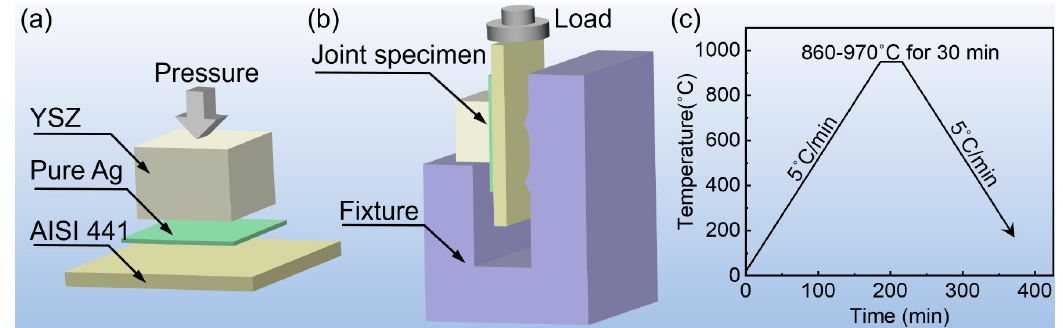
Figure 2. ( a ) Schematic diagram of joining assembly. ( b ) Sketch of the shear test. ( c ) Joining temperature curve.